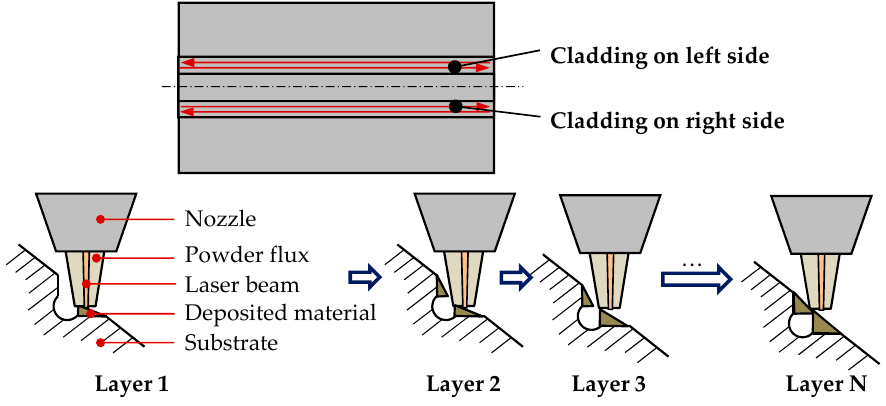
Figure 2. Deposition strategy of the AISI 316L intermediate layer.